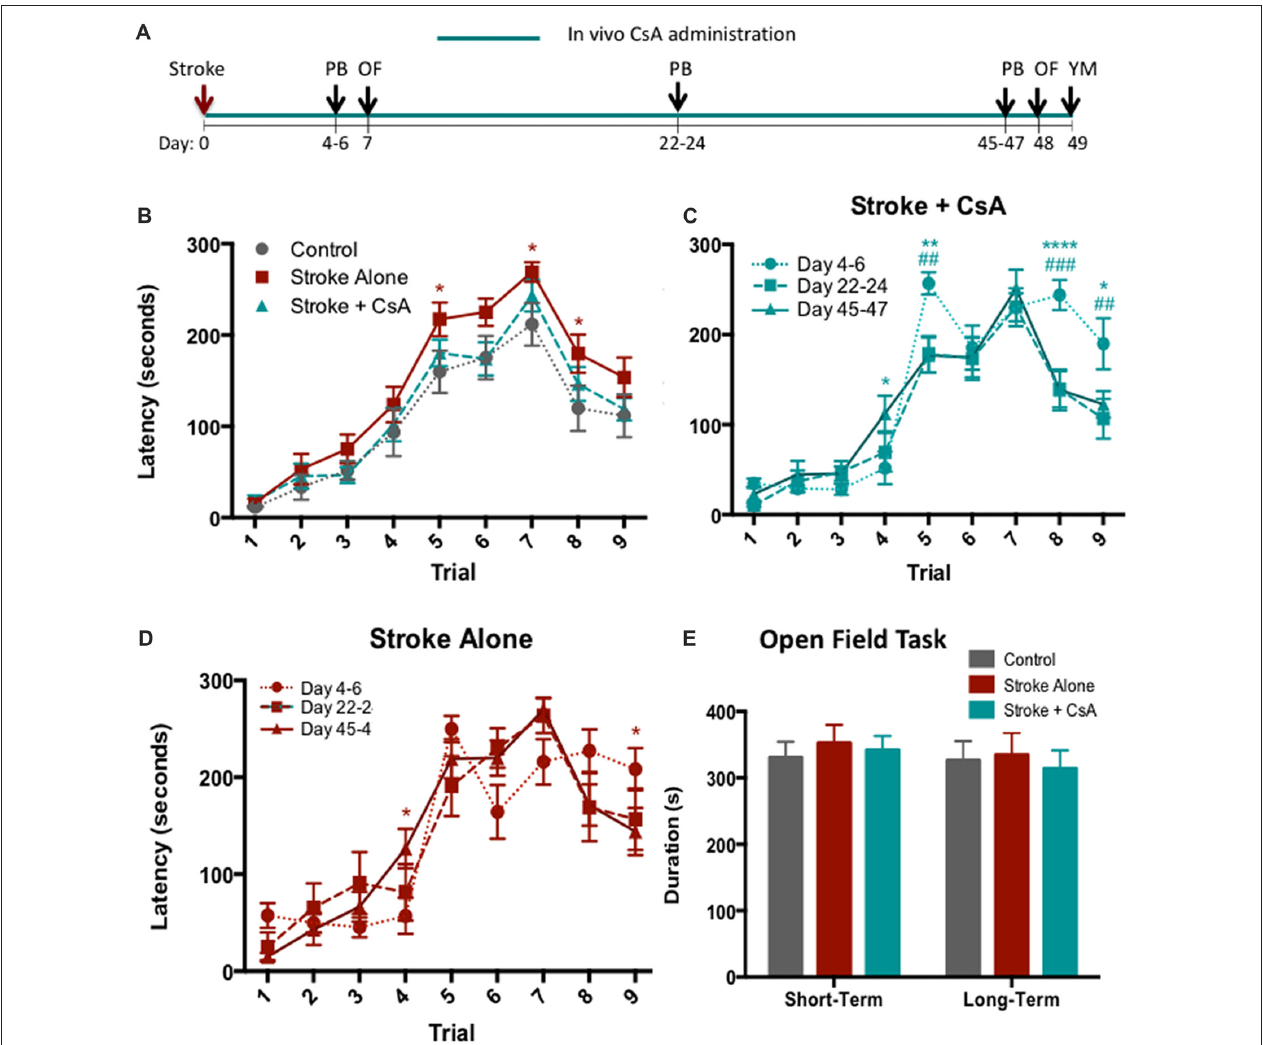
FIGURE 3 | Chronic CsA treatment reduces cognitive impairments. (A) Experimental timeline. PB, puzzle box; OF, Open Field; YM, Y-Maze. (B) Stroke-Alone ( n = 18), but not Stroke+CsA ( n = 16), showed persisting cognitive deficits compared to controls ( n = 14) in the PB task; ∗ p < 0.05. (C) Stroke+CsA animals